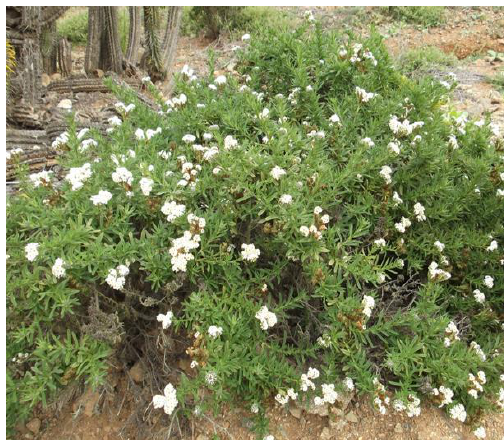
Figure 1. Picture of Heliotropium taltalense collected in Paposo Valley, Atacama Desert, in April